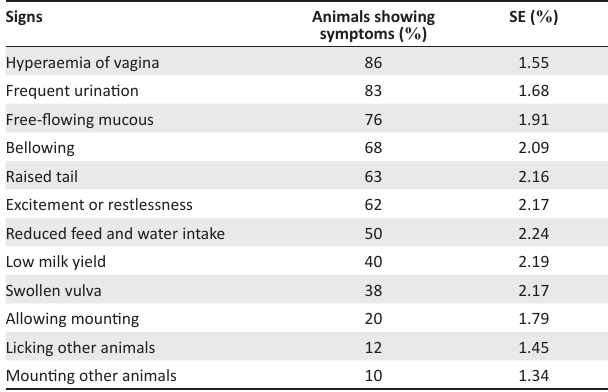
TABLE 1: Percentage of animals showing the particular signs of